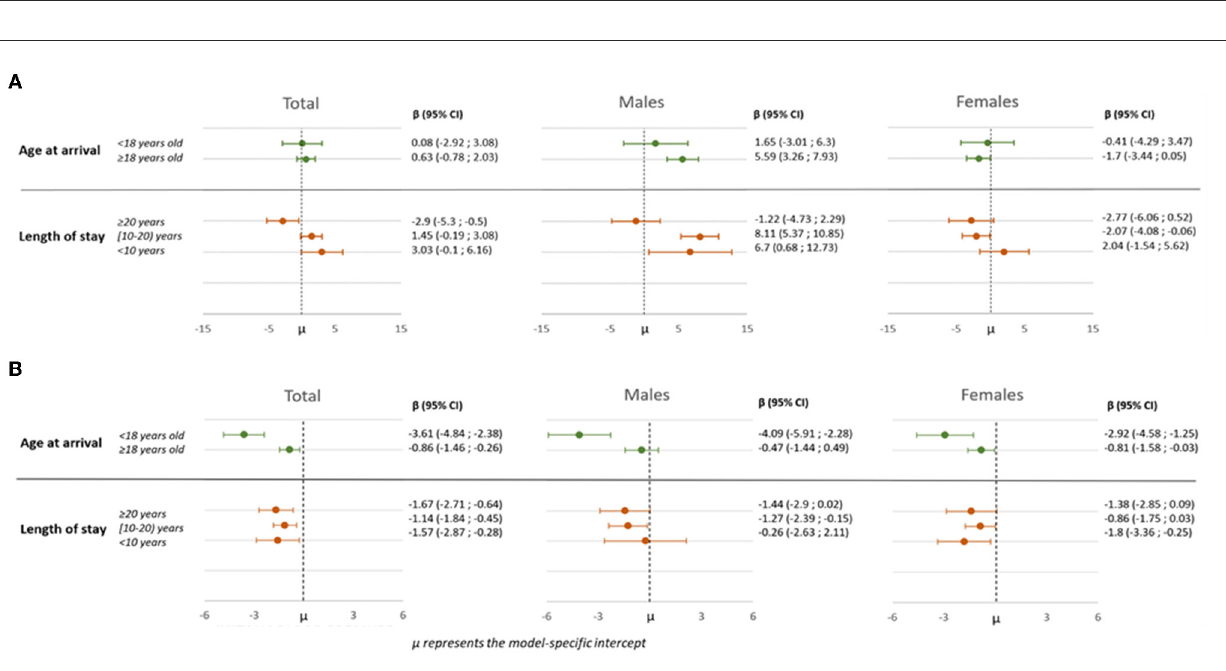
(Supplementary Table S3), immigrants from CE Europe